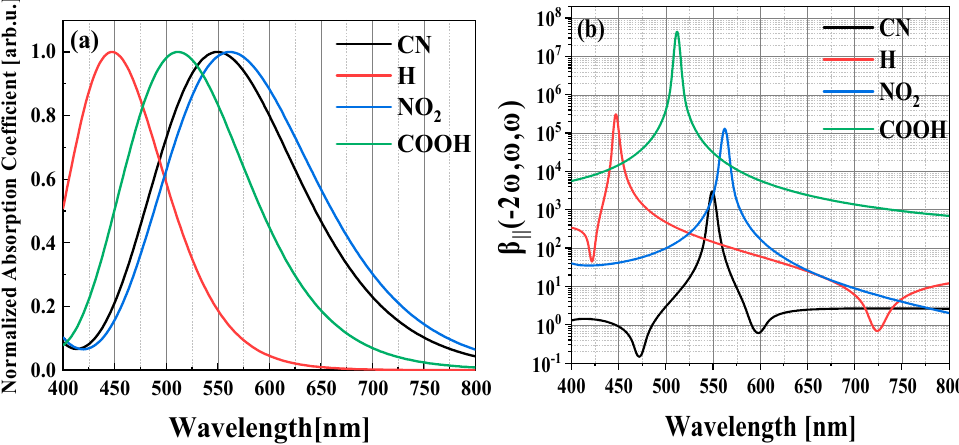
Figure 2. The one-photon absorption spectra ( a ), frequency-dependent second-harmonic generation coefficient spectra ( b